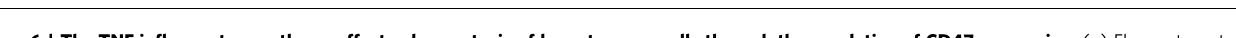
Figure 6 | The TNF inflammatory pathway affects phagocytosis of breast cancer cells through the regulation of CD47 expression. ( a ) Flow cytometry analysis showing TNFR1 expression in the breast cancer line MCF7 (CD47 Hi ), non-tumorigenic breast line MCF10 (CD47 Med ) and HepG2 (CD47 Lo ) hepatoma cancer line shows that TNFR1 expression is higher in the MCF7 breast cancer cells. Mean values of TNFR1-FITC fluorescence are shown in blue to the right of each grey histogram. Grey histograms represent FMO controls. ( b ) Upper figure: A greater increase in CD47 expression is observed in MCF7 when compared to MCF10 or HepG2 cell lines after stimulation with TNF- a (green histogram). Mean values of CD47-APC are shown next to each histogram. Lower figure: Increase in CD47 transcript expression begins to occur after 8h in MCF7 cells and after 24h in HepG2 cells upon TNF- a stimulation. N ¼ 3 samples. Values represent mean þ s.d. Student’s unpaired t -test for independent samples was performed. *** P o 0.001. ( c ) Treating patient-derived xenografted (PDX) and primary patient (PP) breast tumour cells with TNF- a significantly increases CD47 gene expression in four out of five breast tumour samples. Values represent mean þ s.d. Student’s unpaired t -test for independent samples was performed. *** P o 0.001, ** P o 0.01, * P o 0.1. NS ¼ not significant. ER þ PR þ ¼ oestrogen and progesterone positive; TN ¼ triple negative. ( d ) Upper panels: Blocking TNF- a with infliximab reduces CD47 expression regardless of TNF- a stimulation. Lower panels: Blocking TNF- a with infliximab while knocking down NFKB1 causes a greater reduction on CD47 expression regardless of TNF- a stimulation. ( e ) Treating MCF7 with infliximab increases phagocytosis of the cancer cells, and, to a greater extent, if infliximab is combined with CD47 blocking antibody. A more pronounced increase in phagocytosis of the cancer cells was observed for MCF7 cells that have NFKB1 knockdown and were treated with the infliximab and CD47 antibodies combined. N ¼ 6 samples. Values represent mean þ s.d. **** P o 0.0005,